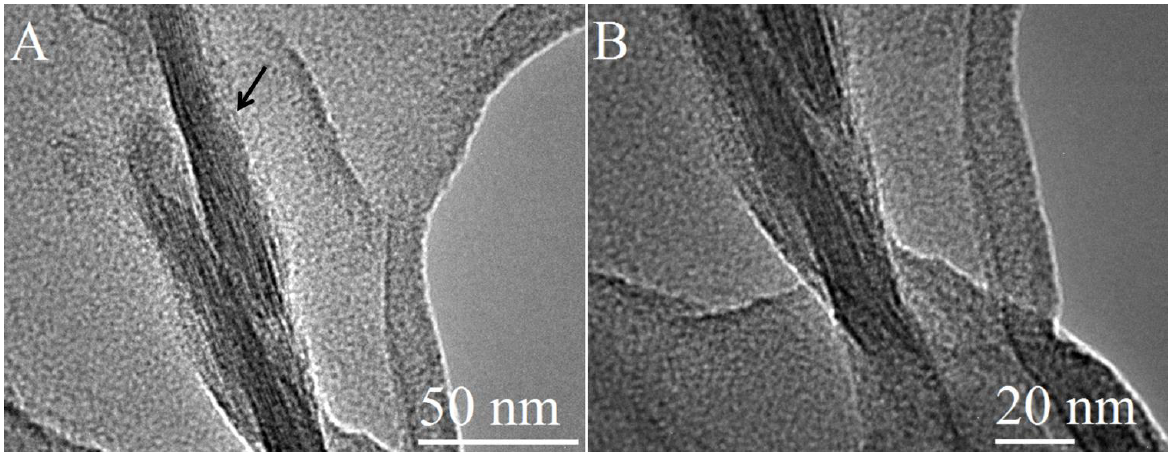
Figure 6. TEM images of Na +